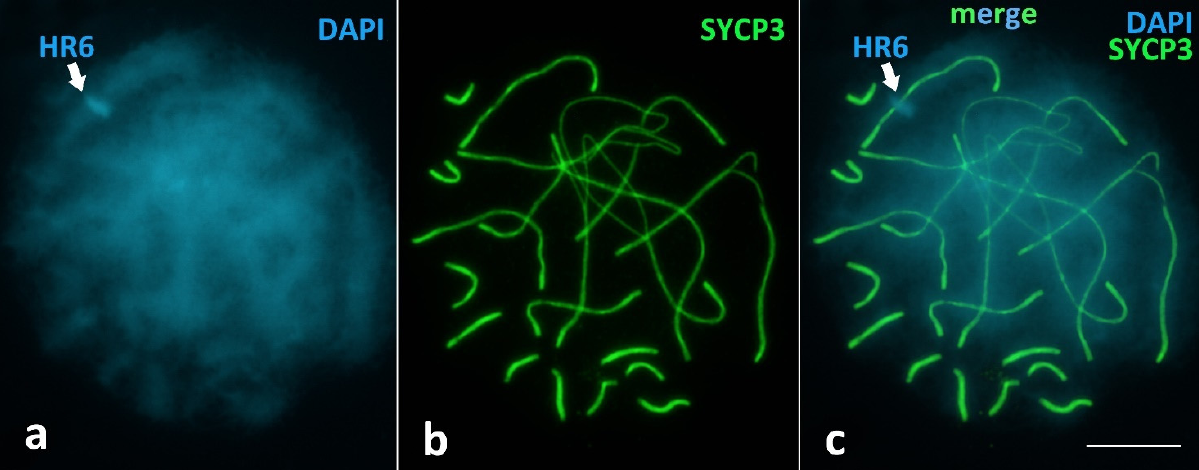
Figure A2. Late zygotene stage, V. berus spermatocyte I. Heterochromatin region on the bivalent 6 (HR6) after the synapsis of two homologous chromosomes 6. ( a ) Chromatin stained with DAPI (blue), ( b ) Axial elements of chromosomes are immunostained with antibodies against the SYCP3 protein (green), and ( с ) merge. Bar—10 μ m.